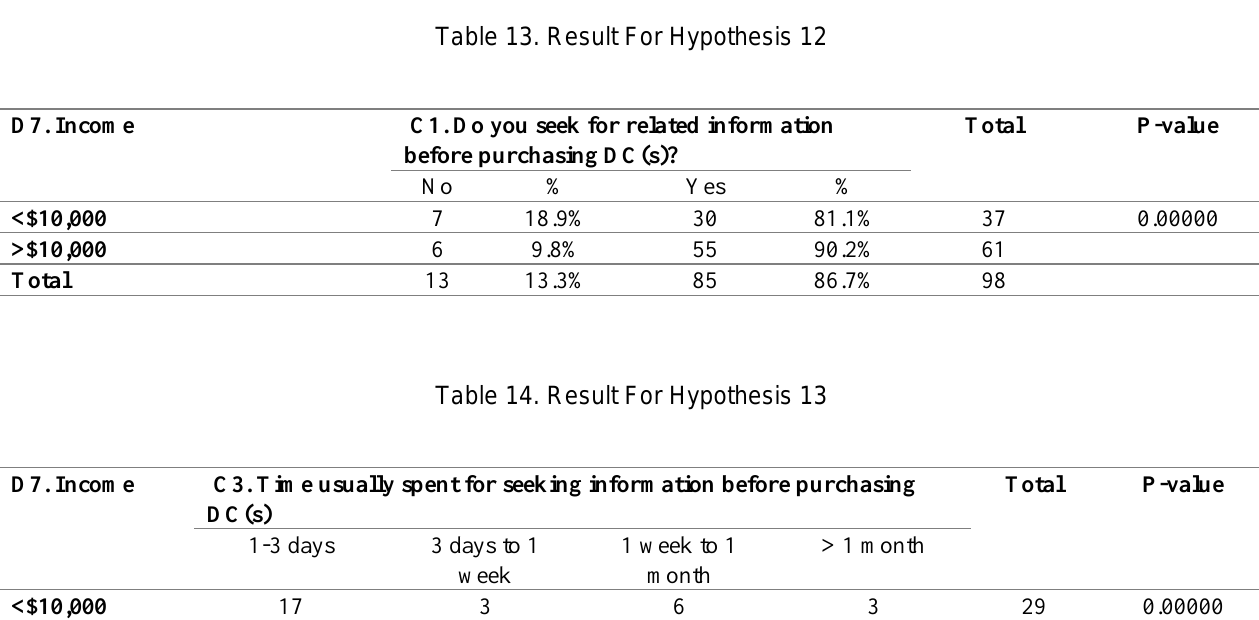
Table 13. Result For Hypothesis 12